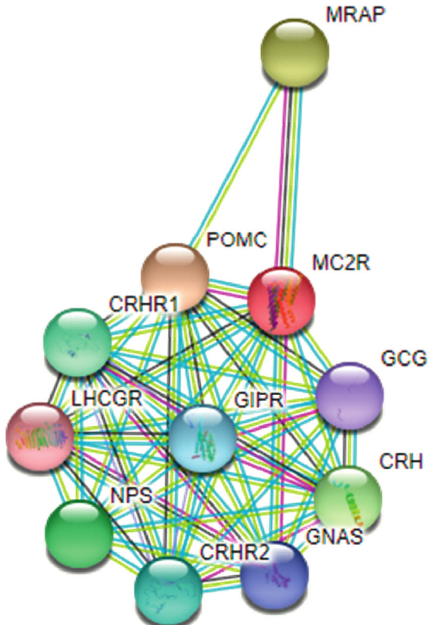
Figure 5: Interactome analysis by STRING (V10.5). Protein-protein interaction network; predicted functional partners are as follows: POMC: proopiomelanocortin, MC2R: melanocortin-2 receptor, CRH: corticotropin-releasing hormone, GNAS: GNAS complex locus, CRHR2: corticotropin-releasing hormone receptor 2, NPS: neuropeptide S, LHCGR: luteinizing hormone/choriogonadotropin receptor, CRHR1: corticotropin-releasing hormone receptor 1, and MRAP: melanocortin-2 receptor accessory